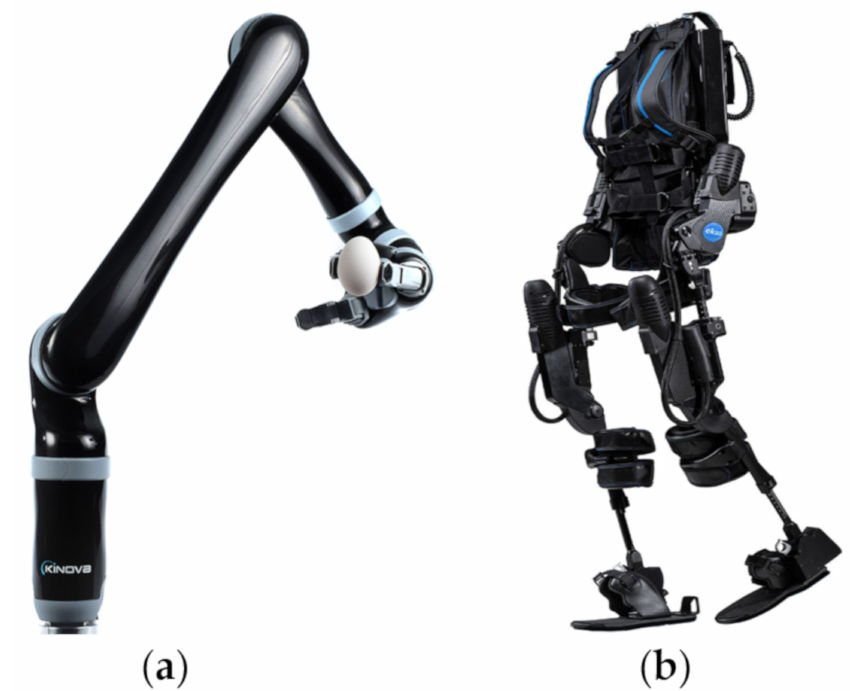
Figure 15. Rehabilitation and assistive robots. ( a ) Kinova assistive robotic arm [69]. ( b ) EksoNR exoskeleton